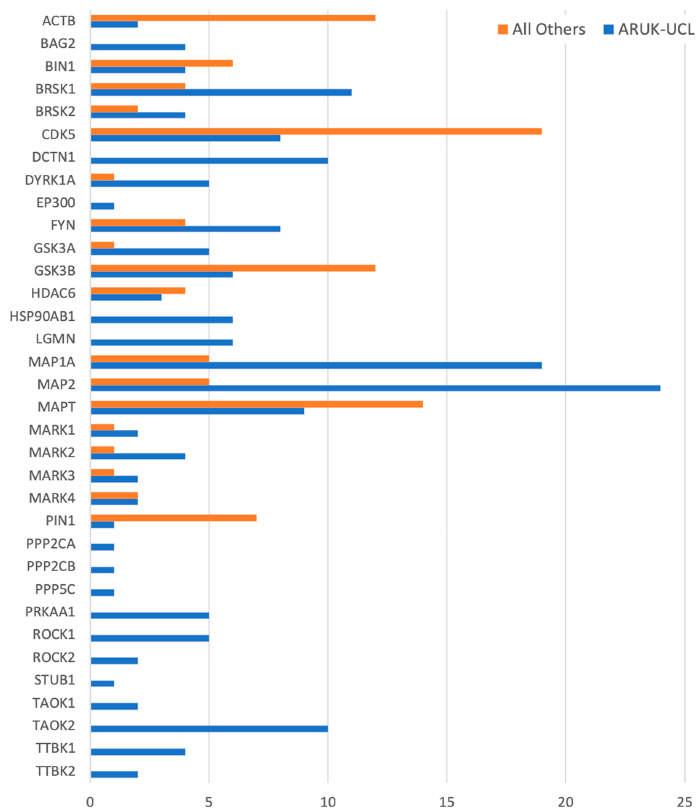
Figure 3 . A histogram of all the manually curated neurological annotations for the prioritised tau-relevant human gene products, including annotations contributed by ARUK-UCL as well as by other groups. Data for this figure was derived from Table